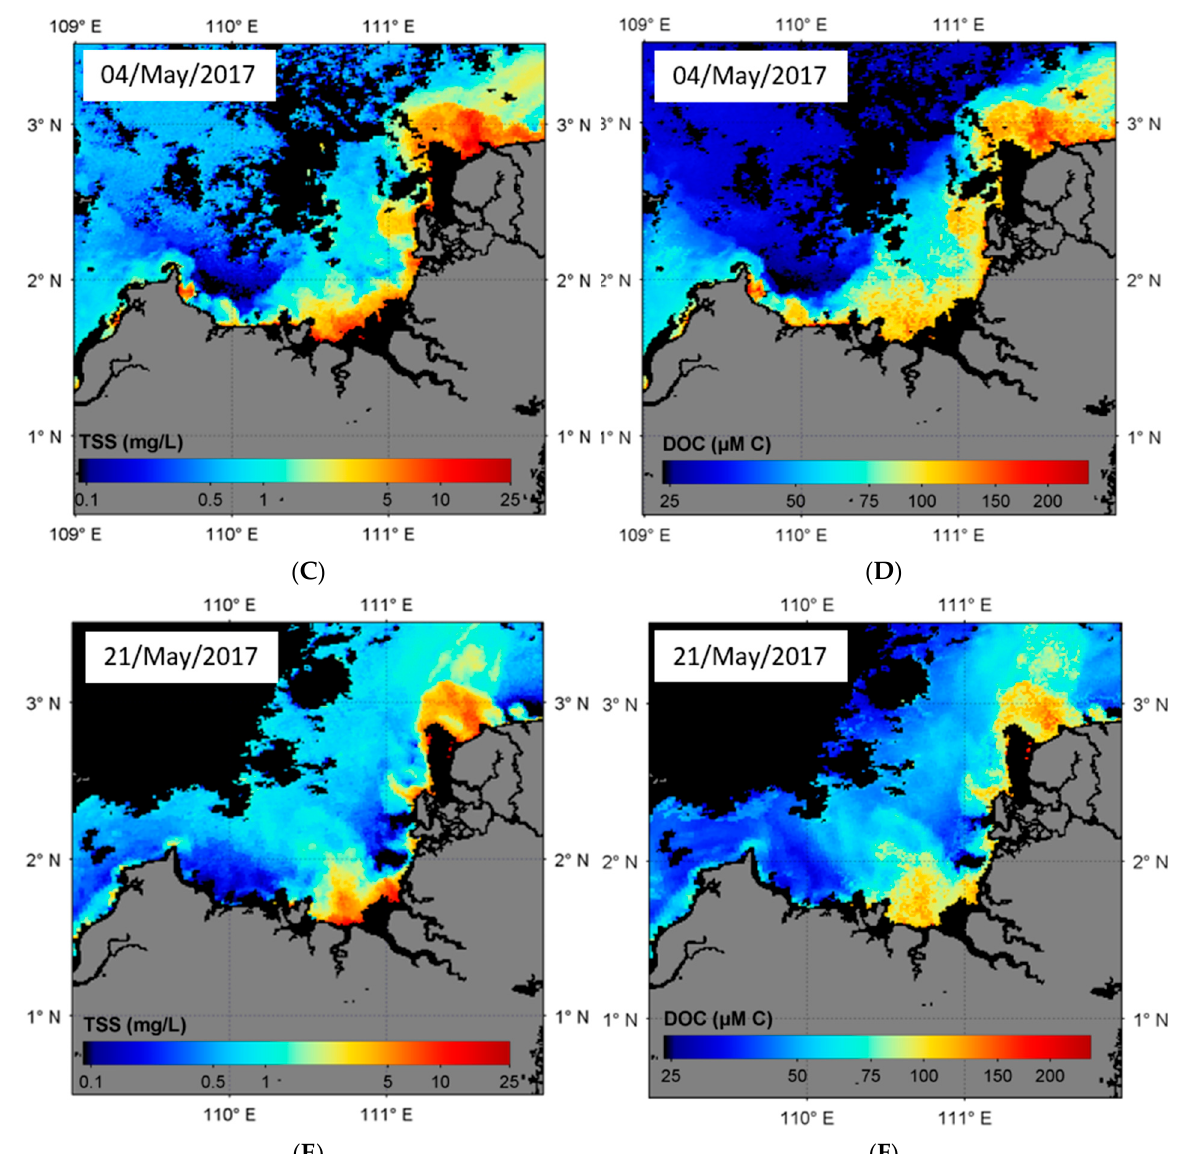
Figure 11. Temporal variability in TSS and DOC concentrations across Sarawak coastal waters as observed by MODIS Aqua. ( A , B ) Spatial maps of TSS and DOC for 23 January 2017, representing north-east monsoon conditions. Higher concentrations of TSS and DOC are observed in the river plumes in front of the Rajang, Lupar and Sadong rivers. ( C , D ) Spatial maps for 4 May 2017 (south-west monsoon conditions) show strong river discharges near the Samunsam and Sematan rivers in the western coastal waters of Sarawak, with higher magnitudes of TSS and DOC discharged into the coastal waters. ( E , F ) Spatial maps for 21 May 2017 show higher concentrations of TSS and DOC discharged into coastal waters by the Igan and Rajang river mouths, and relatively clear waters over a wide region across the western part of coastal Sarawak.